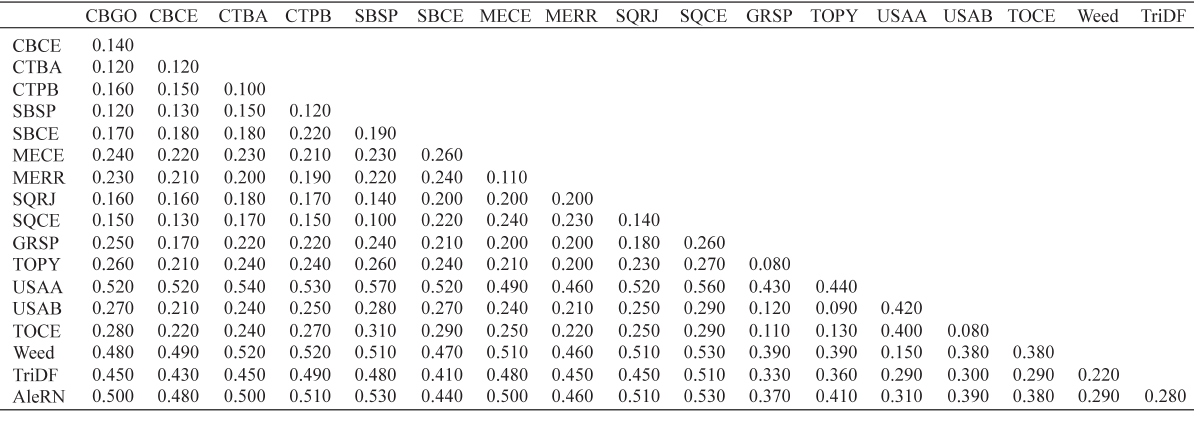
Table II - Manhatan’s distance matrix between B. tabaci populations and two other whitefly species. Population codes are listed in Table I.